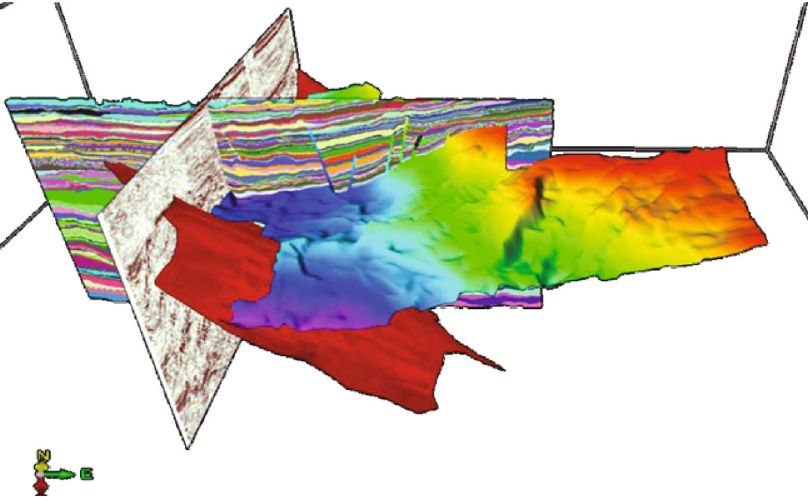
Figure 2: Horizon picking and 3D stratigraphic model section.